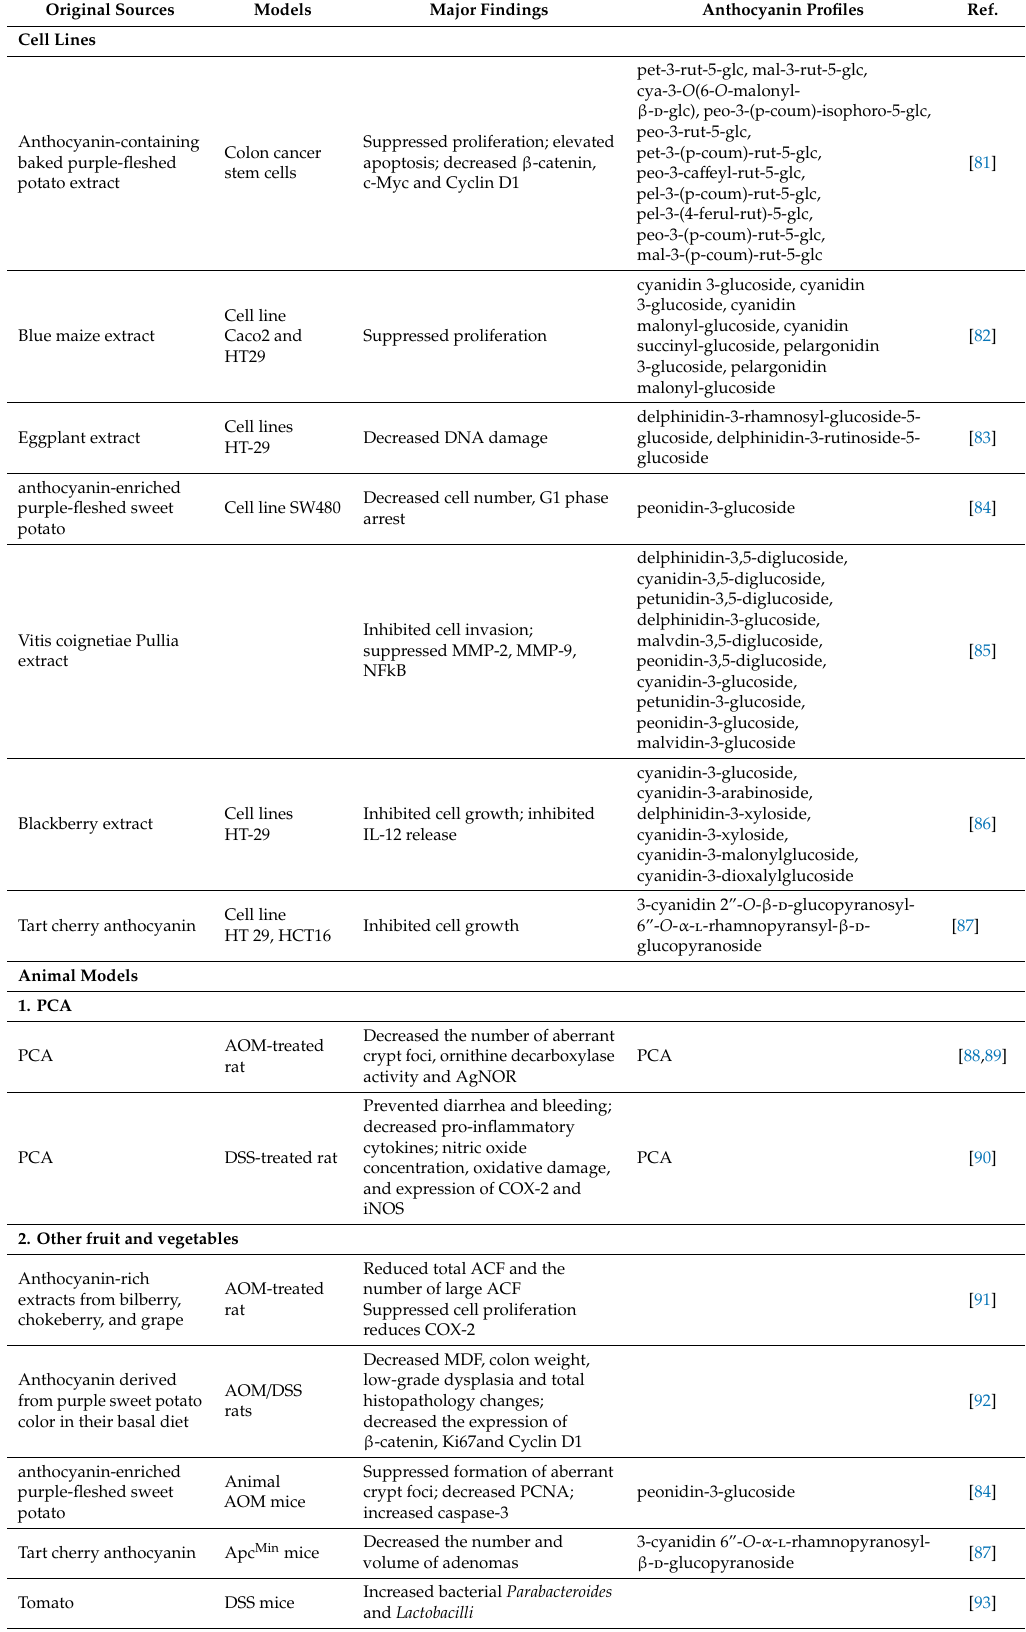
Table 4. E ff ects of anthocyanins in IBD and IBD-related